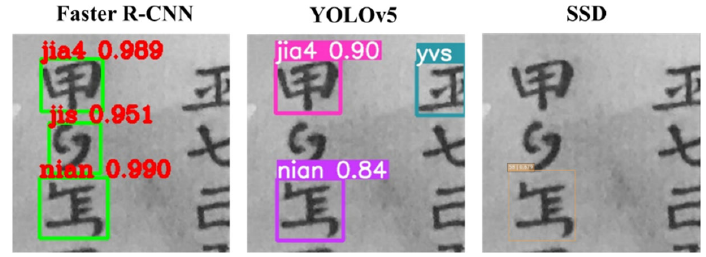
Figure 6. Image test results of Faster R ‐ CNN, YOLOv5, and SSD.